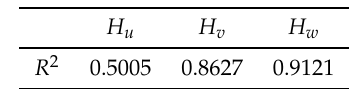
Table 11. Coefficients of determination for H k .